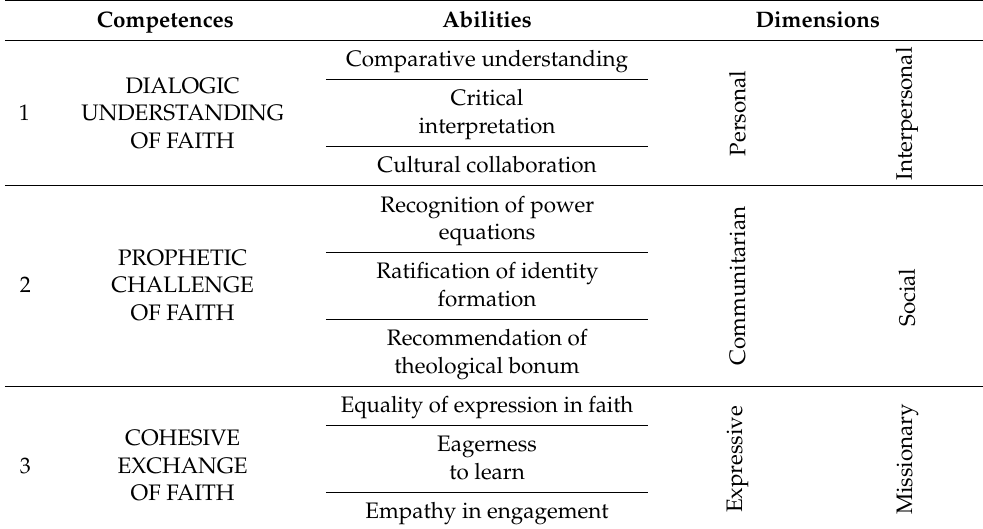
Table 1. Intercultural Theology Competences for Faith